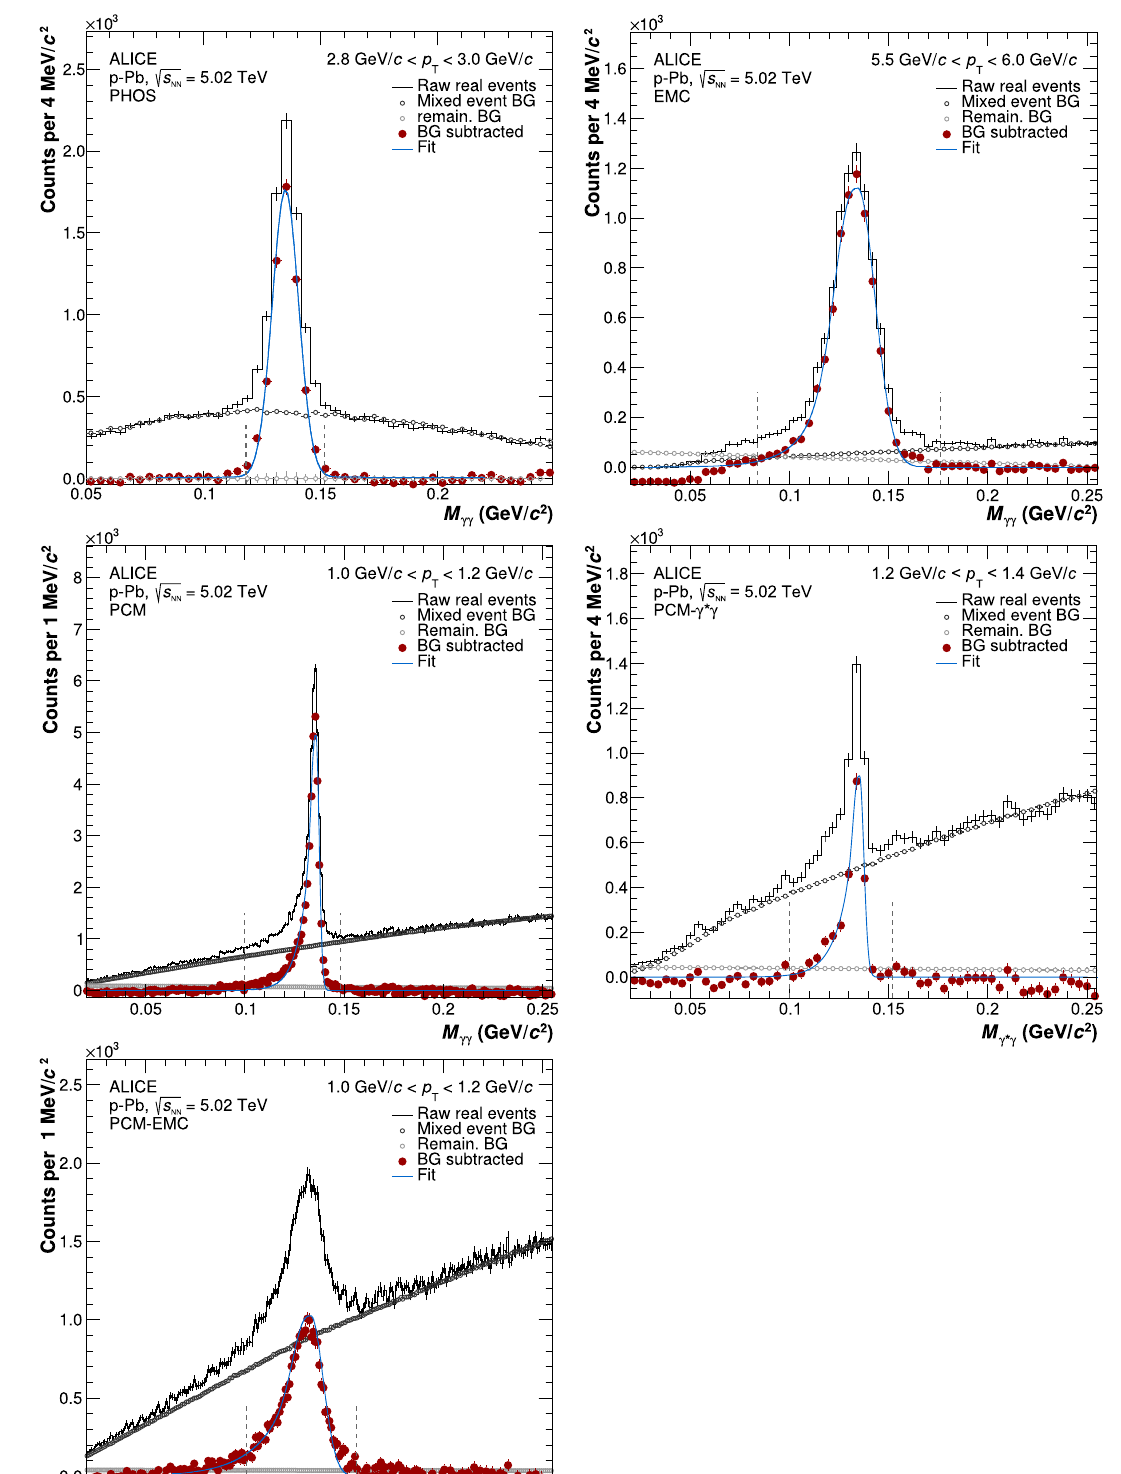
Fig. 1 The diphoton invariant mass distributions around the π 0 mass for selected intervals in p T , without and with combinatorial background for each of the five measurements: PHOS, EMC, PCM, PCM- γ ∗ γ , and